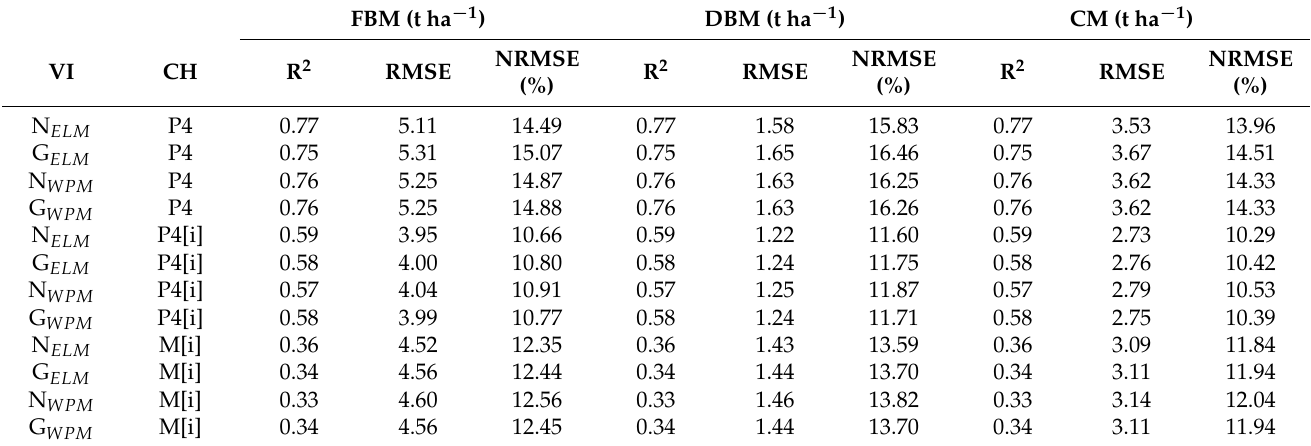
Table 4. Results of the linear regression analyses for both calibration methods (WPM, ELM) of both VIs (G: GnyLi, N: NRI) and the estimated (by three different CH) crop traits: fresh and dry biomass and the crop moisture. Three CH: P4: P4RTK crop height, M: manual crop height, [i]: interpolated crop height values. ( p < 0.001 for all regression